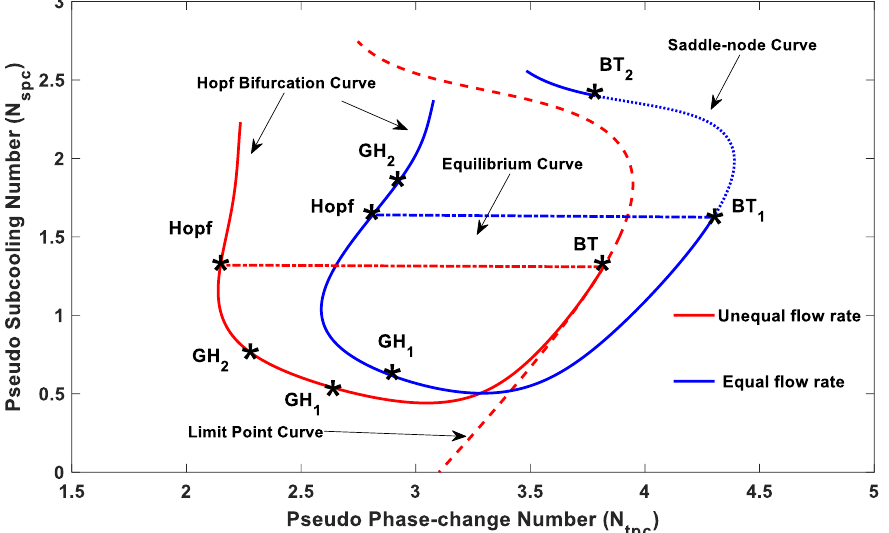
Figure 8. Stability threshold in the N tpc − N spc space for supercritical water at h fd = 1.1.